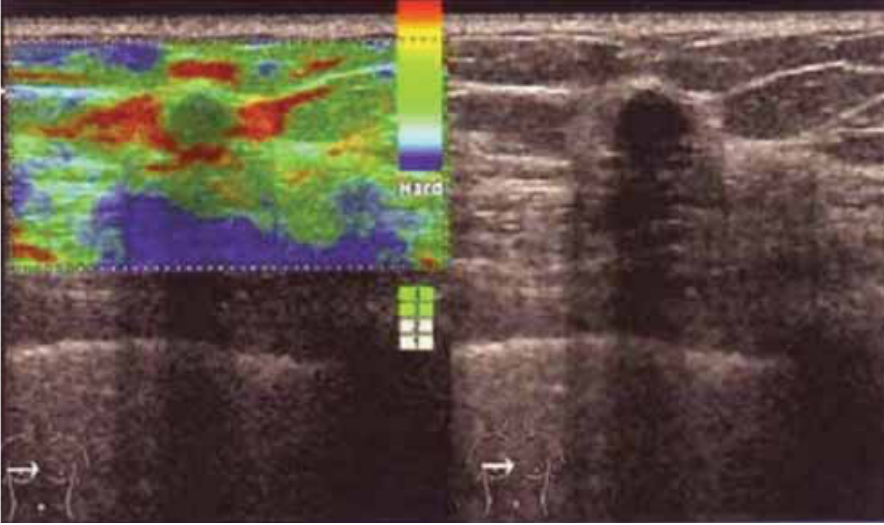
FIGURE 3. Fibroadenoma with elasticity score 2. On conventional B-mode image, the lesion